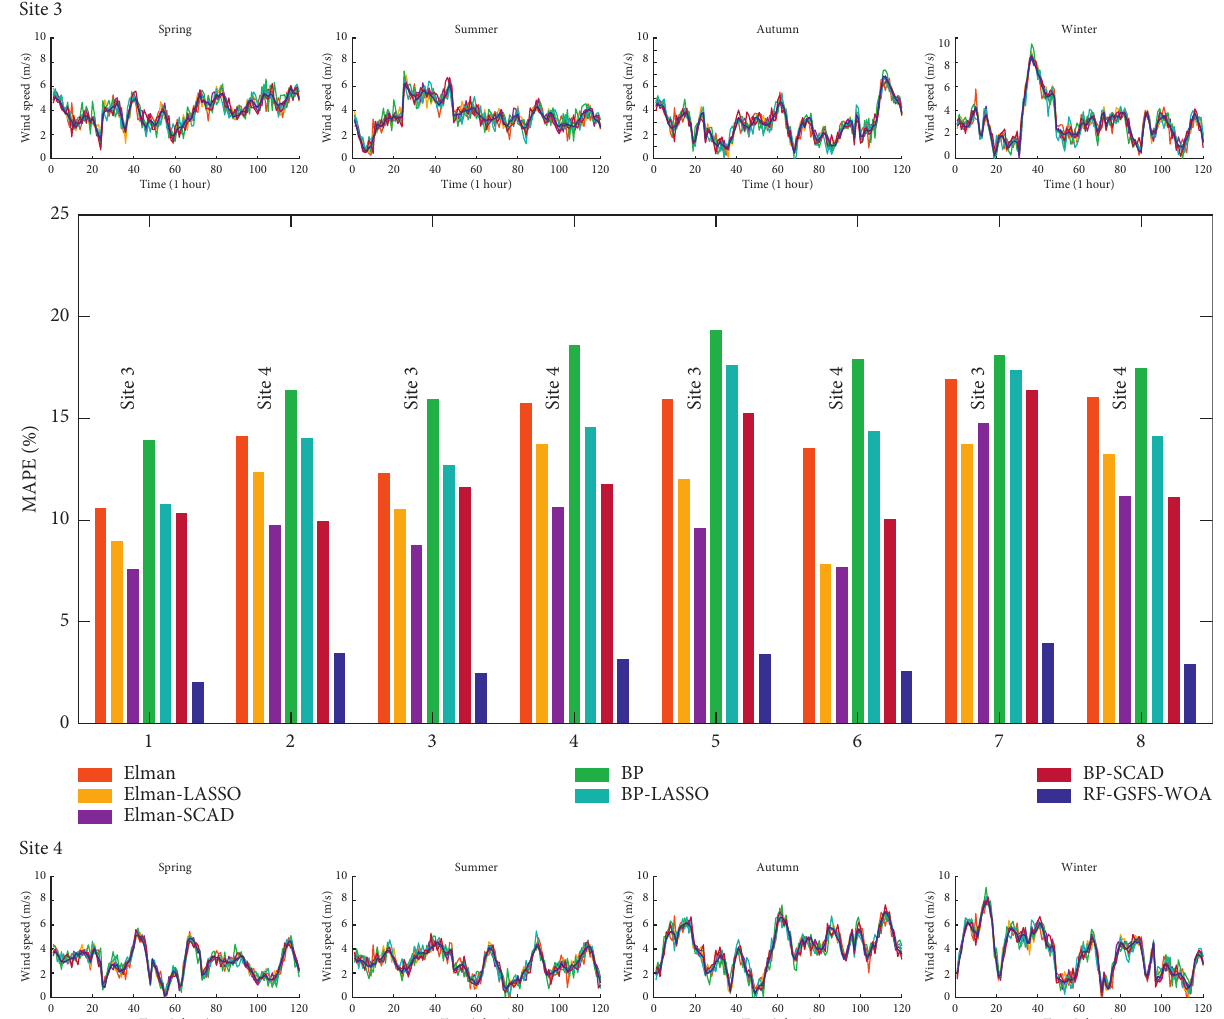
Figure 6: Forecasting results of seven models at Site 3 and Site